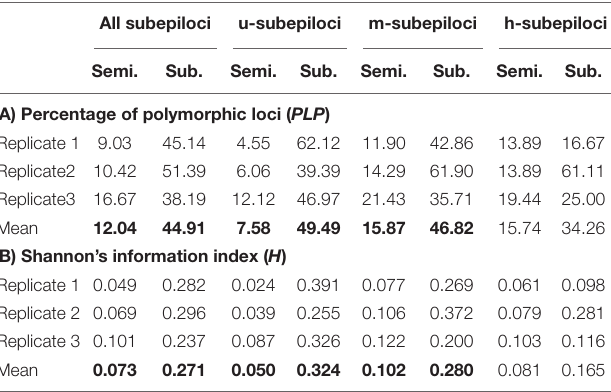
TABLE 1 | Epigenetic diversity of the six clonally propagated populations of Hydrocotyle vulgaris under semi-submergence (Semi.) and submergence (Sub.) as quantified by (A) percentage of polymorphic loci and (B) Shannon’s information index based on all subepiloci and u-, m-, and h-subepiloci of